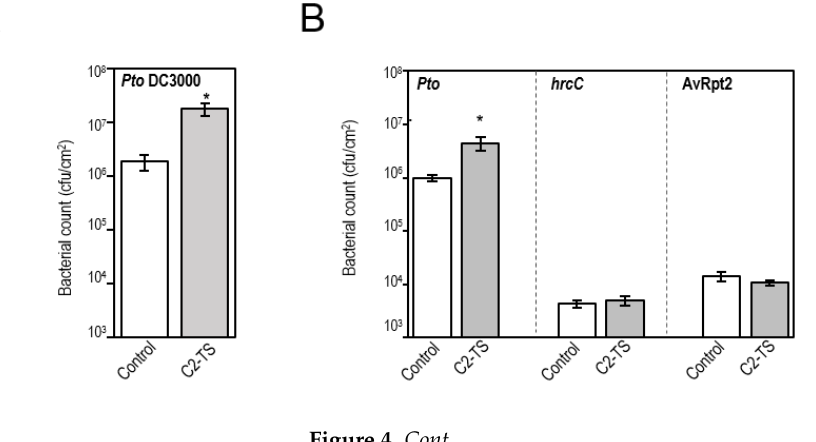
Figure 4. Cont. Figure 4.